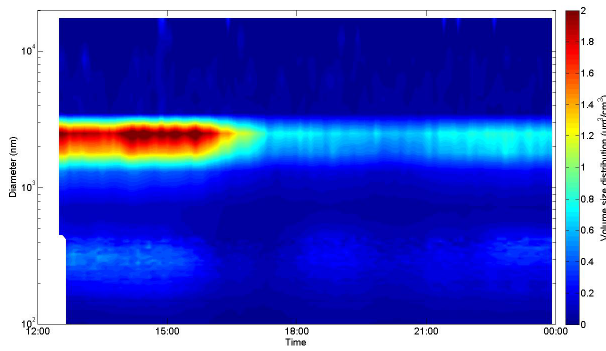
Fig. 4. Particle volume size distribution measured by a SMPS and Grimm OPC on 19 May 2010 at the Puy de